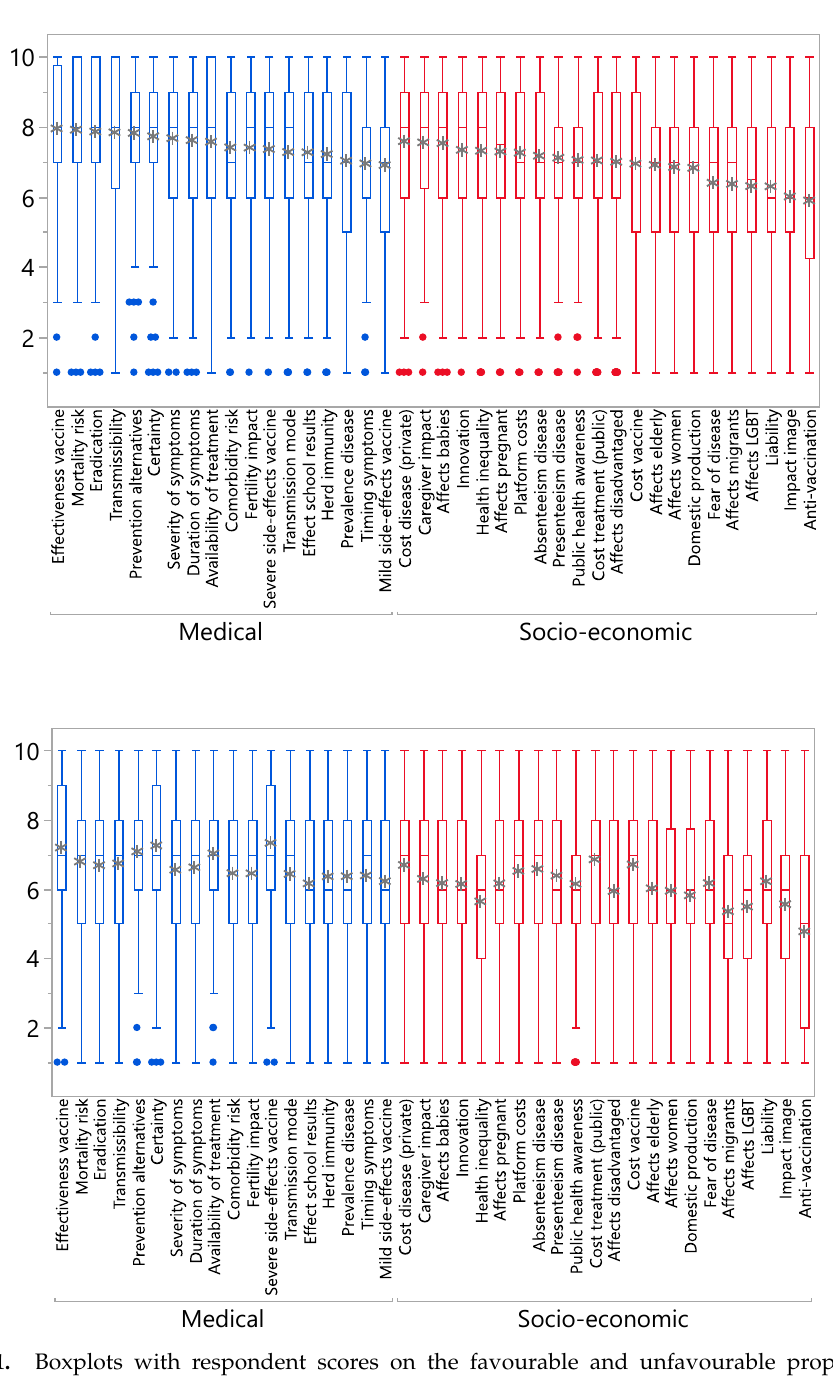
Figure 1. Boxplots with respondent scores on the favourable and unfavourable propositions. Upper panel: favourable propositions, lower panel: unfavourable propositions.